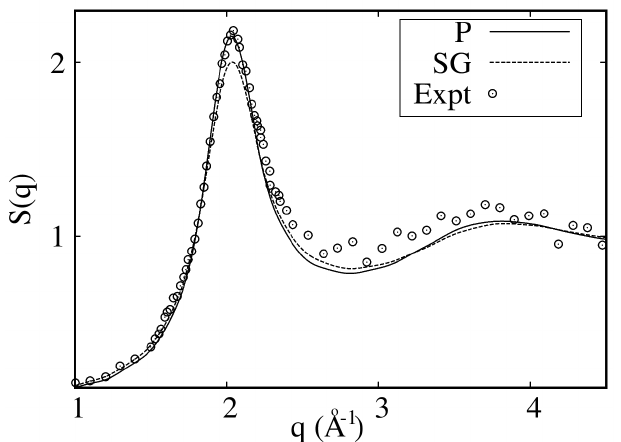
Figure 2. Static structure factor of liquid p -H 2 at density n = 0.02295 Å − 3 and temperature T = 17.1 K, computed in this work using the SG (doted line) and P (solid line) intermolecular pair potentials. Also shown (circles) are experimental results from Ref. [37]. Experimental uncertainties are not shown for clarity but they are typically of the order of 0.1 for q ≥ 3 Å − 1